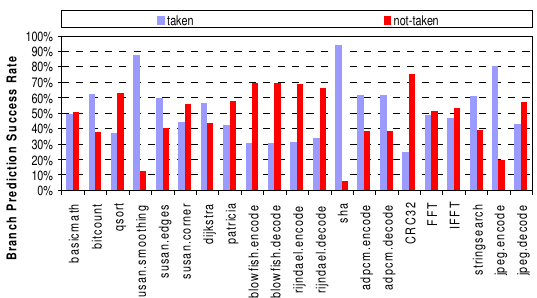
Figure 6. IPC results for a static branch predictor using an always taken and always not-taken heuristics.